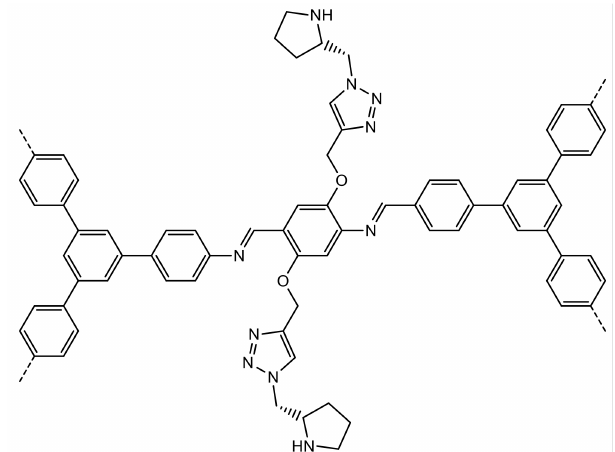
Figure 15. Schematic representation of the chiral [( S )-Py] x -TPB-DMTP-COF. Recently, several other COFs have been used for various applications in asymmetric catalysis. For instance, COFs containing pyrrolidine derivatives for Steglich rearrange- ment [187] and aldol condensation [188]; TADDOL ligand derivatives for aldehyde